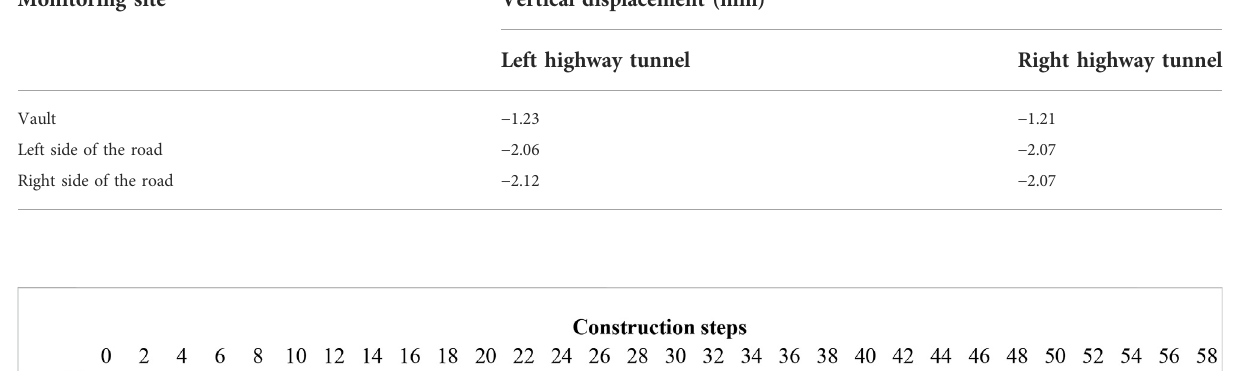
TABLE 2 Maximum vertical displacement of monitoring sites.